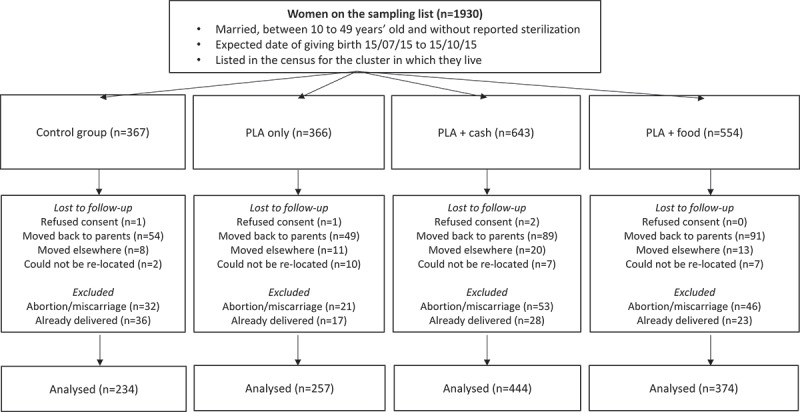
Sampling strategy and trial flow.